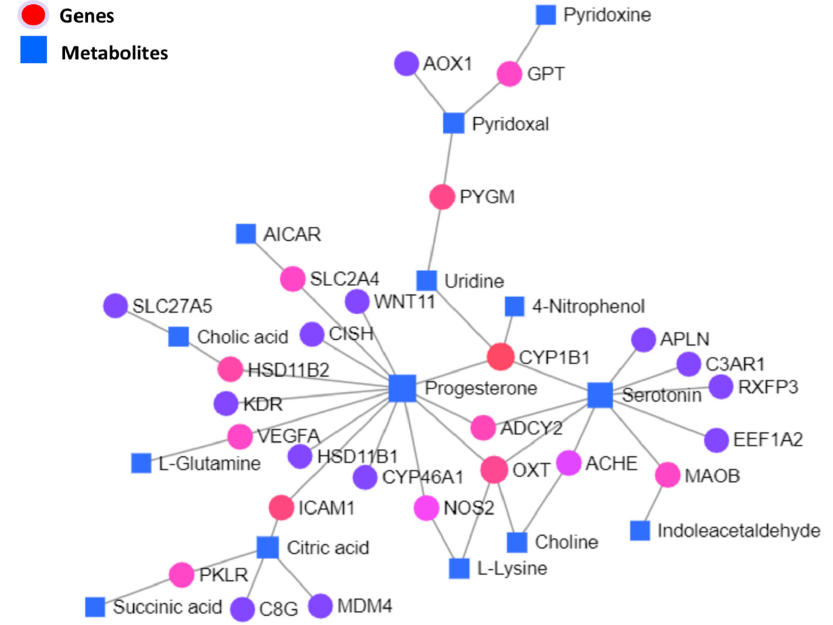
Figure 7. Integrated network illustration of differential genes and metabolites based on the KEGG database. Where circular nodes represent genes, square nodes represent metabolites as labeled. Color variations of gene nodes from red to violet are based on the degree of connections in the network. Table 4. Statistical details of the top interaction nodes found in the joint network analysis of genes and metabolites, along with their regulation statuses in heat-stressed granulosa cells. “Degree” denotes the number of direct connections between the nodes; “Betweenness” shows the centrality of the given interaction.